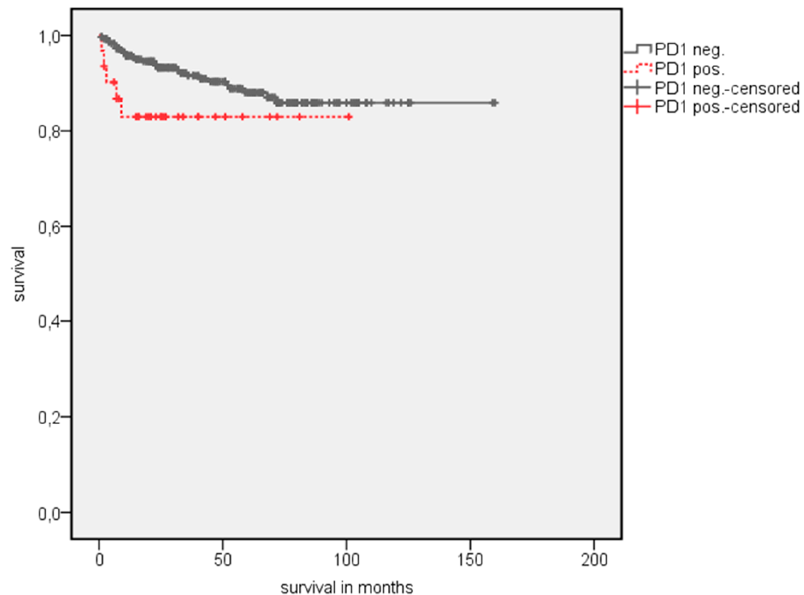
Figure 2. Kaplan Meier analysis: Association of PD1 expression in tumor-infiltrating mononuclear cells (TIMC) with overall survival (OS) in all RCC patients.